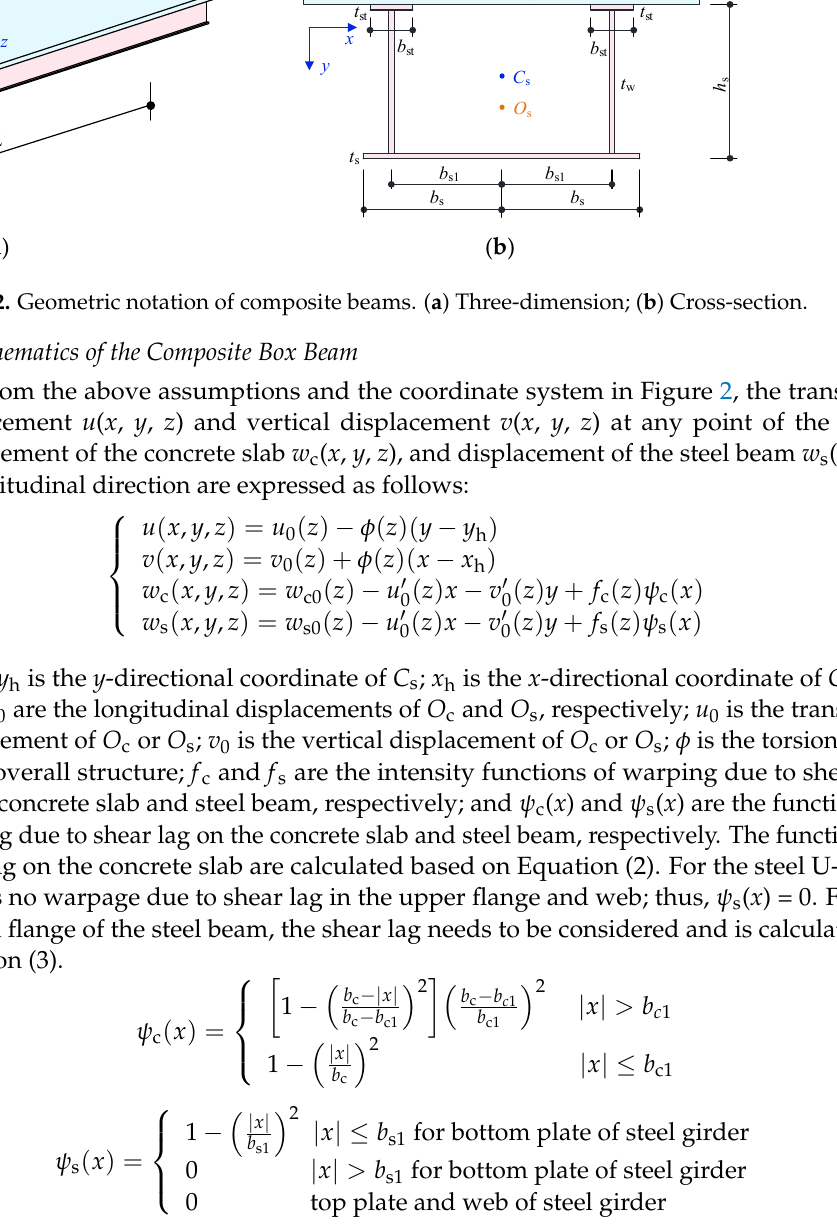
Figure 2. Geometric notation of composite beams. ( a ) Three-dimension; ( b ) Cross-section.